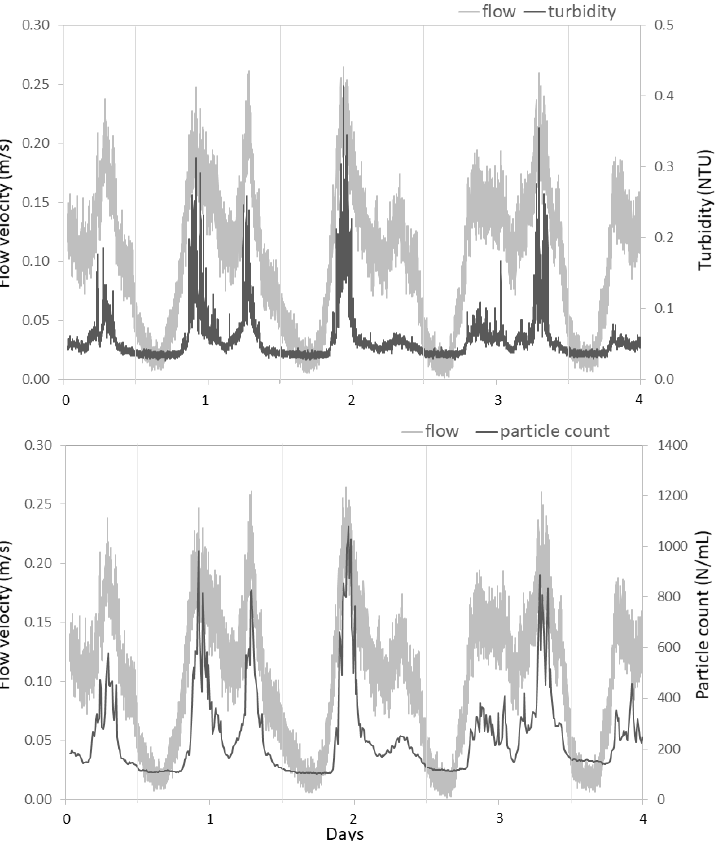
Figure 4. Variations over four days of flow velocity compared to turbidity ( top figure ) and the number of particles of 1 to 2 µm size ( bottom figure ) at distribution location E. For comparison purposes, the flow velocity data shown on the top and bottom figures are identical. Flow velocity and turbidity data are presented as moving averages. Vertical lines indicate the time at 0:00 of each day.